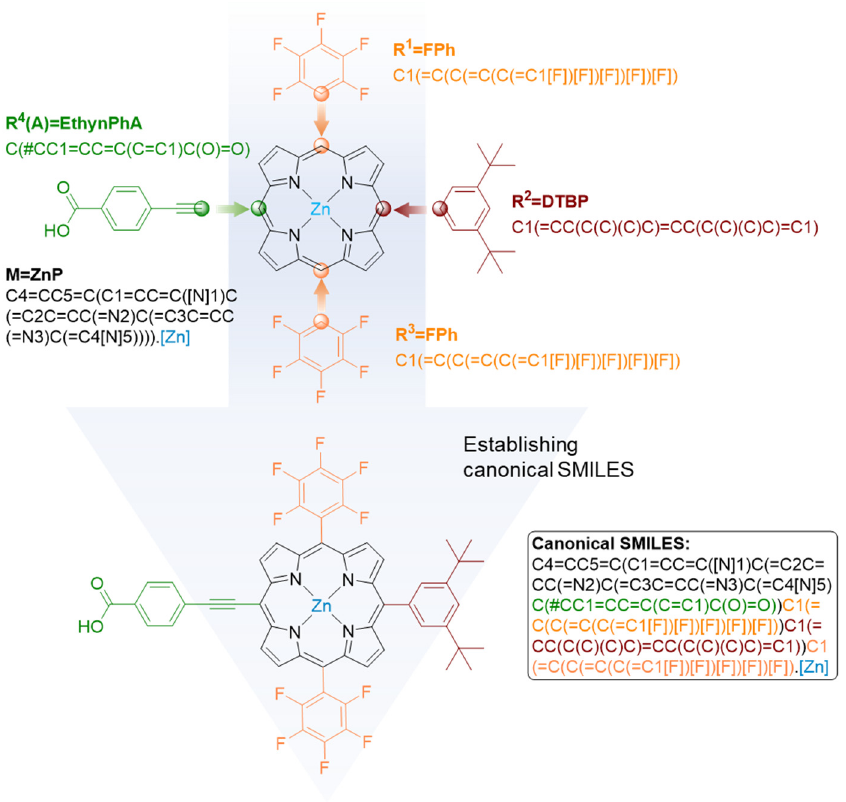
Figure 2. Procedures of assembling a canonical SMILES for a porphyrin/metalloporphyrin molecule.